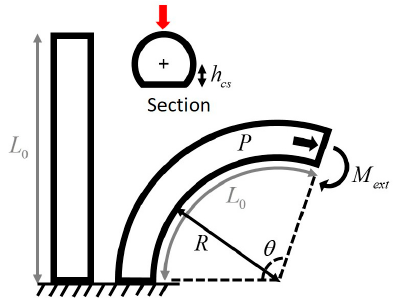
Figure 4. Main variables of the bending-actuator model. The red arrow indicates the location of maximum strain.